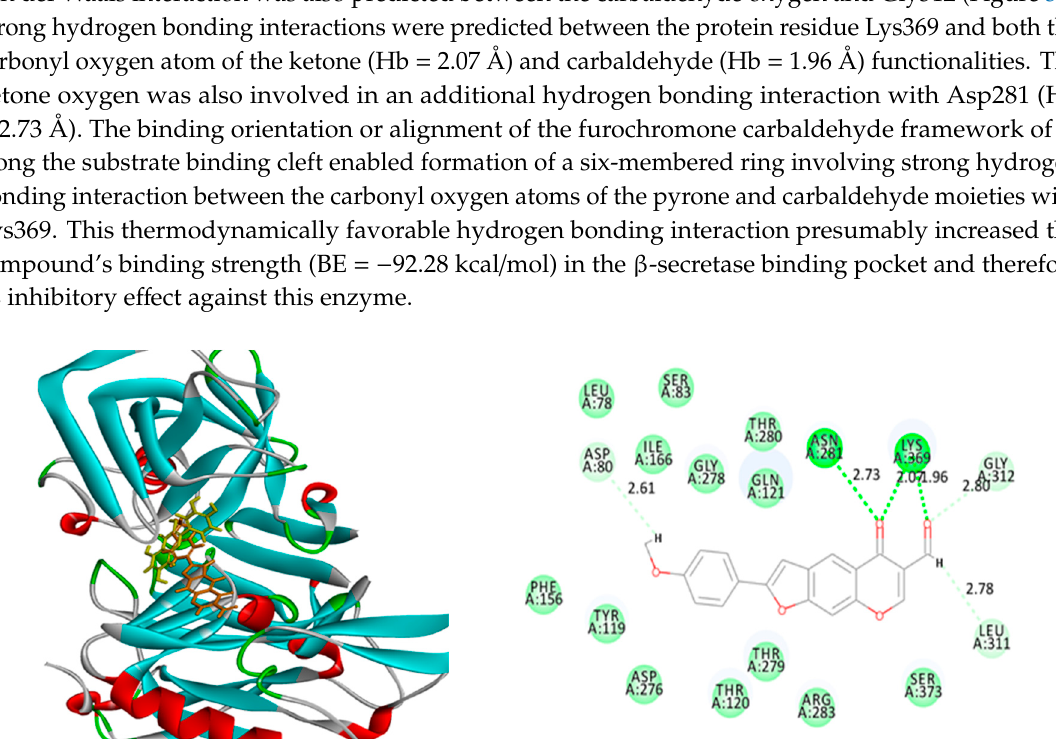
( a ), and 2D docking plot for 2f including bonding interaction distances ( b ). Bright green represents